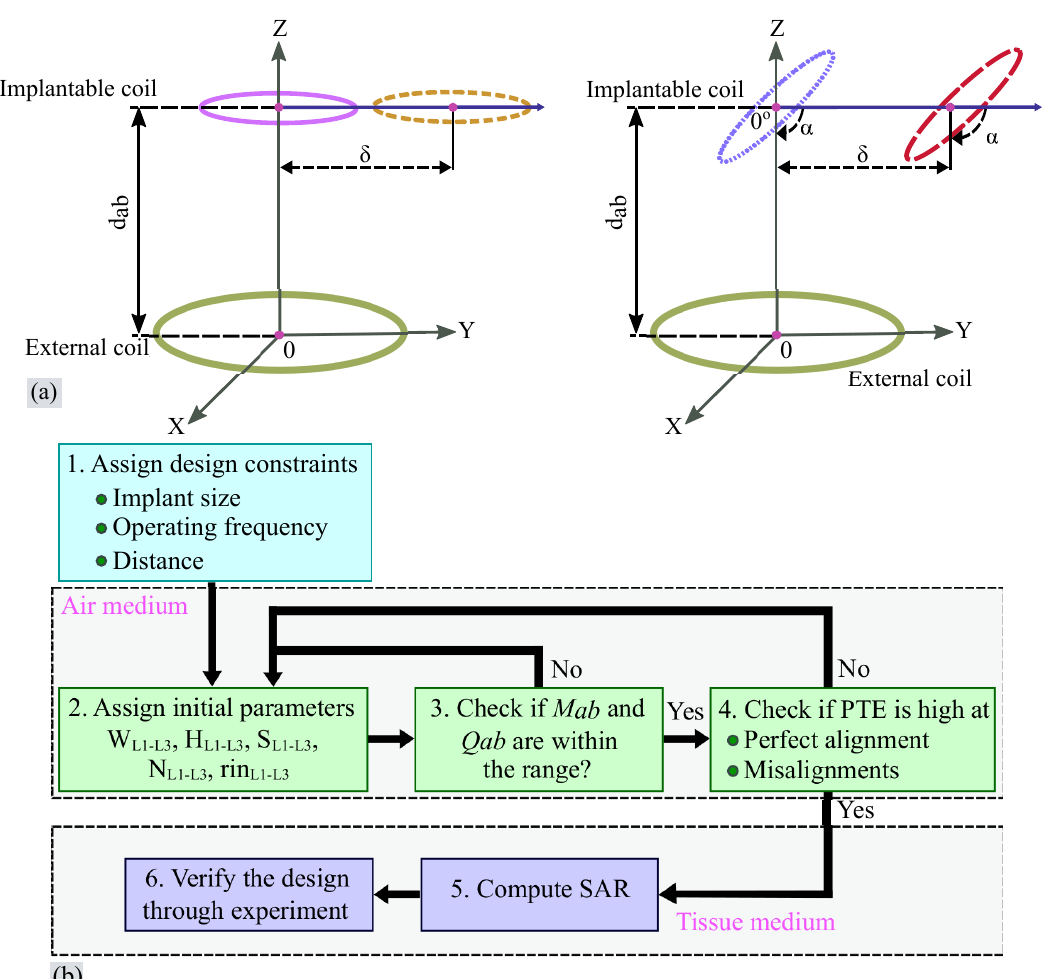
Figure 3. ( a ) Orientation of the external and implantable coils; ( b ) Flowchart of the optimization procedure of a 3-coil inductive